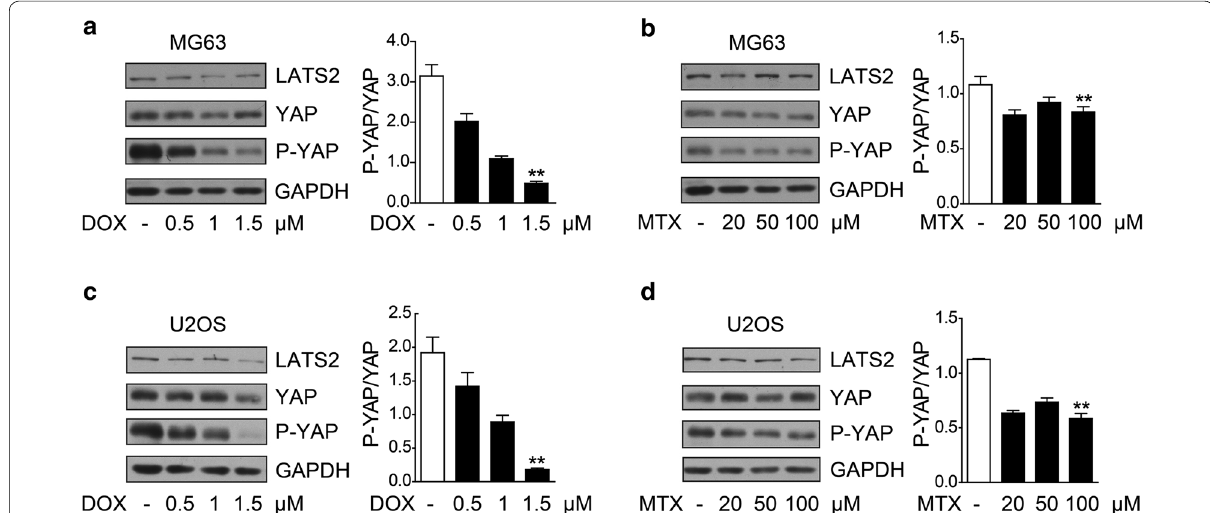
Fig. 2 MTX and DOX induce YAP activation in MG63 and U2OS osteosarcoma cells. a , b Left panel Western blotting representative image of large tumor suppressor kinase 2 (LATS2), YAP, and YAP phosphorylation at Ser127 in MG63 cells with indicated concentrations of MTX or DOX treatments. Right panel Grayscale comparison of phosphorylated YAP to YAP total protein. Data are shown as mean ** P < 0.01. YAP phosphorylation level at Ser127 and LATS2 protein level in MG63 cells was decreased by MTX and DOX. c , d Left panel Western blot‑ ting representative image of LATS2, YAP, and YAP phosphorylation at Ser127 in U2OS cells with indicated concentrations of MTX or DOX treatments. Right panel Grayscale comparison of phosphorylated YAP to YAP total protein. Data are shown as mean ** P < 0.01. YAP phosphorylation level at Ser127 and LATS2 protein level in U2OS cells was decreased by MTX and DOX. P-YAP YAP phosphorylation